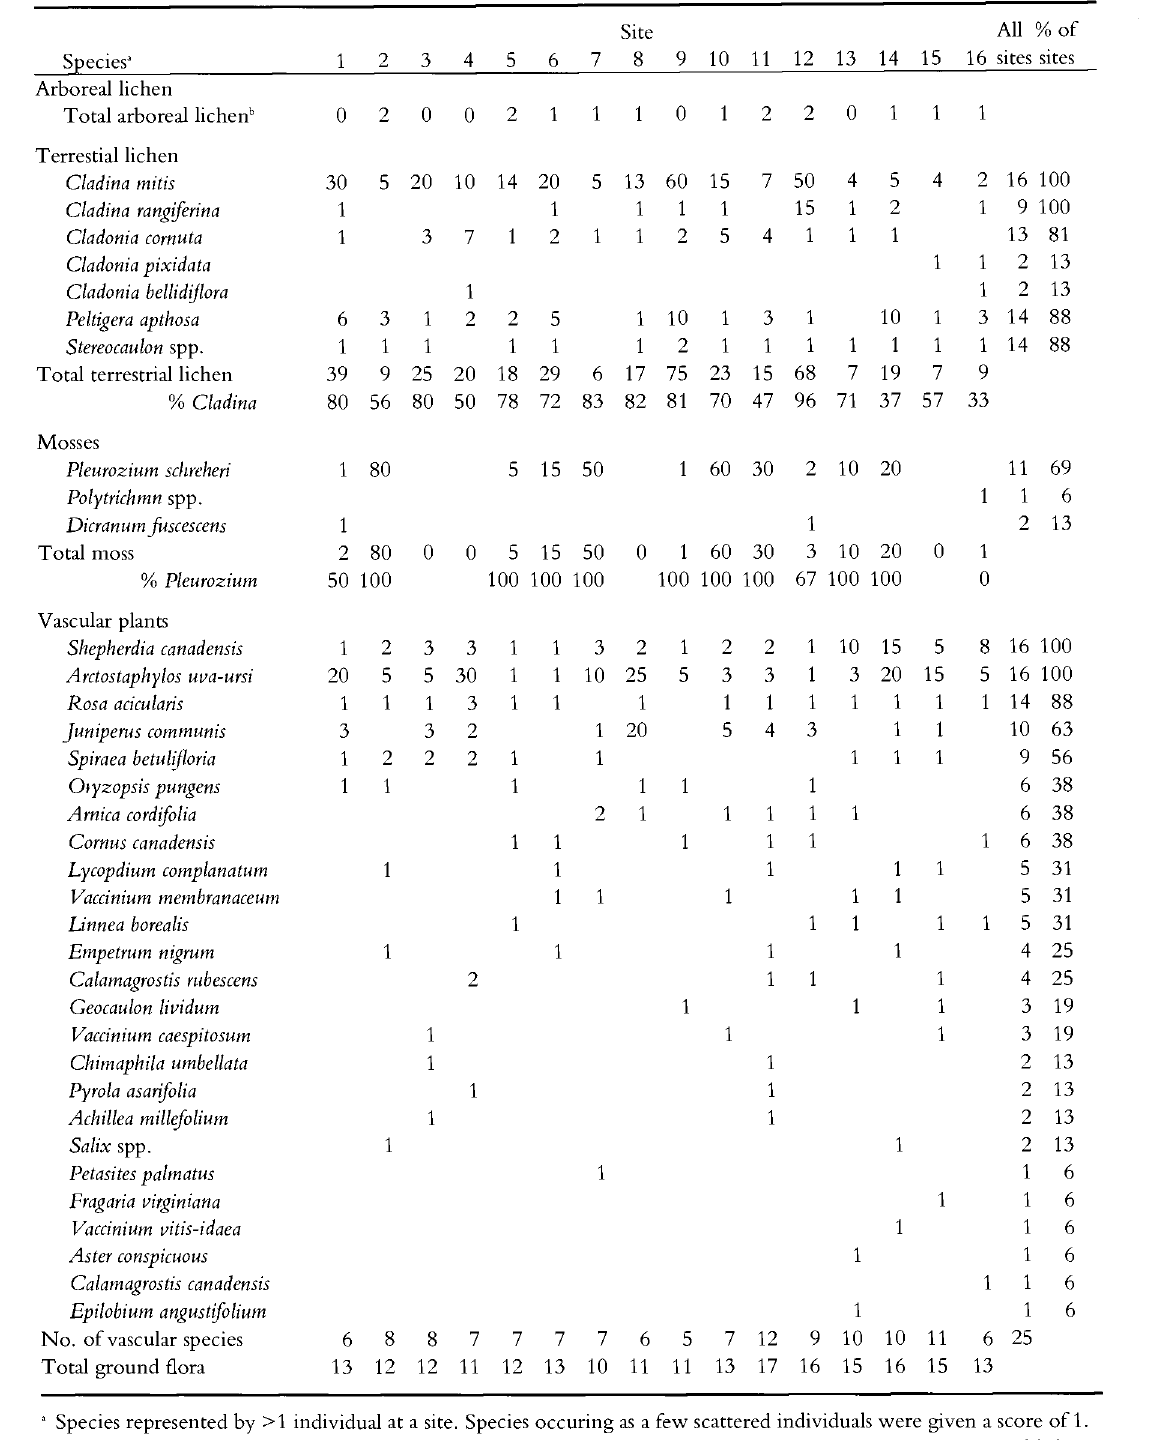
Table 3. Plant species content (percentage cover) of the sample sites.